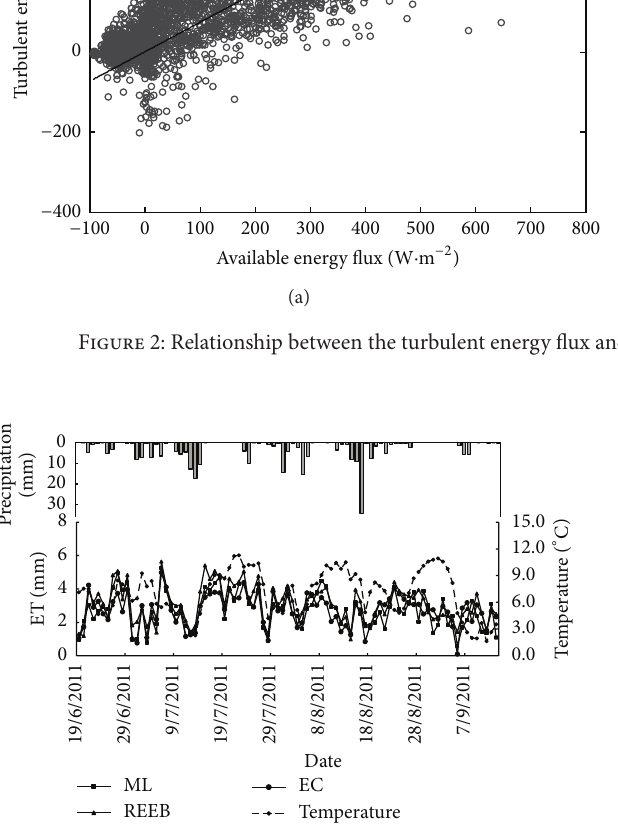
Figure 3: Daily variation of air temperature, precipitation, and evapotranspiration (ET) estimated by three methods during the observation